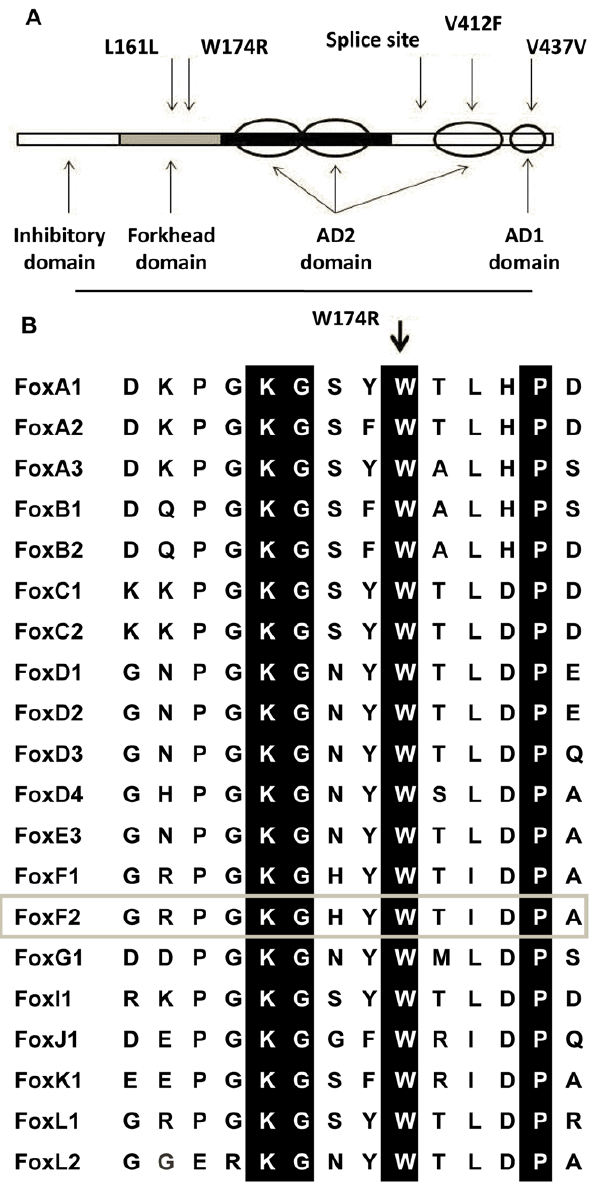
projections of tissue forming the ciliary body processes are clearly visible in wildtype littermates (Figure 6A). However, there was no evidence of tissue evagination in the homozygote embryos (Figure 6B). Heterozygous mice at this stage appear indistinguish- able from wildtype mice.